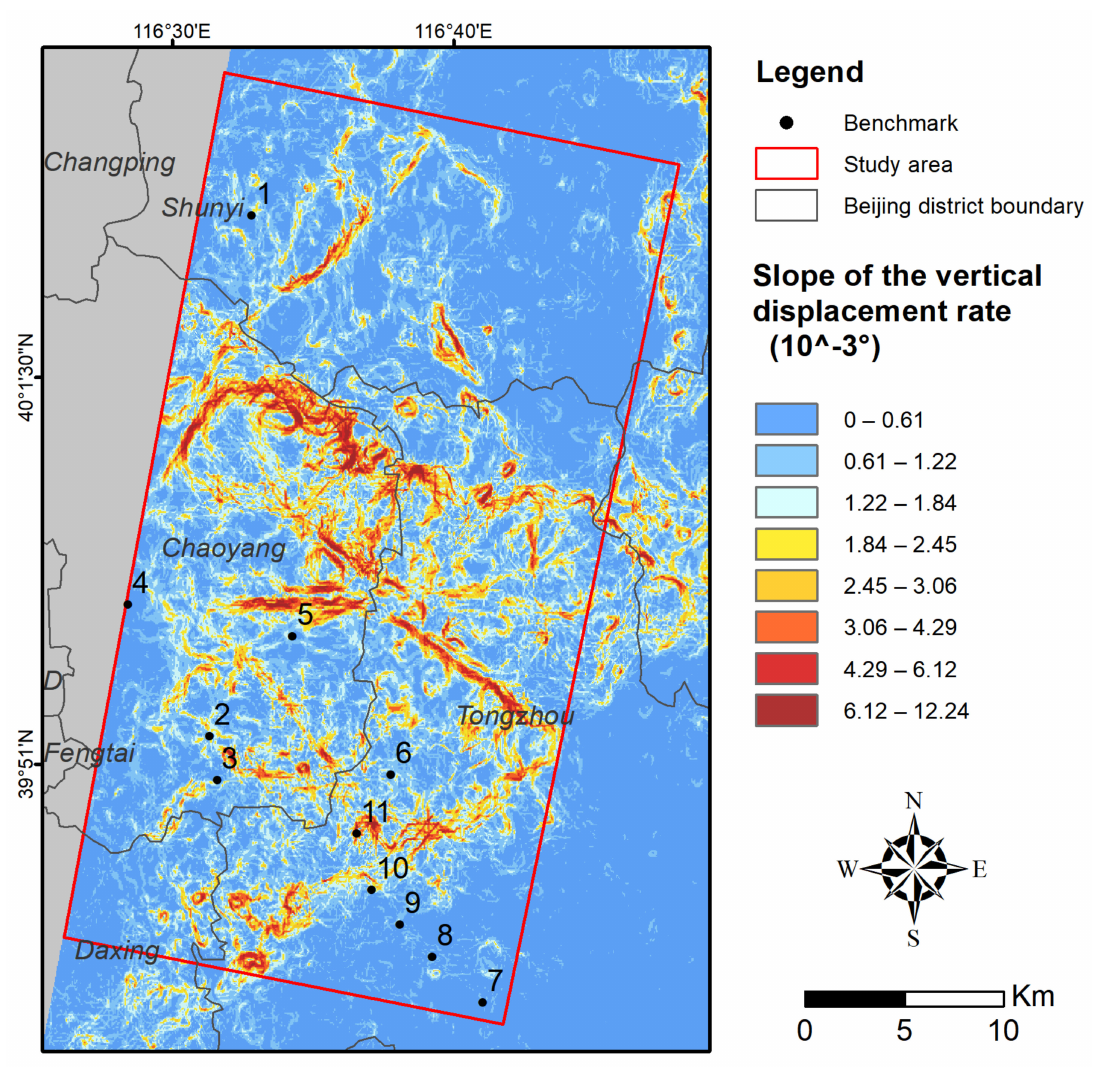
Figure 5. Slope of the vertical displacement rate. 1–11 in the image is the order of